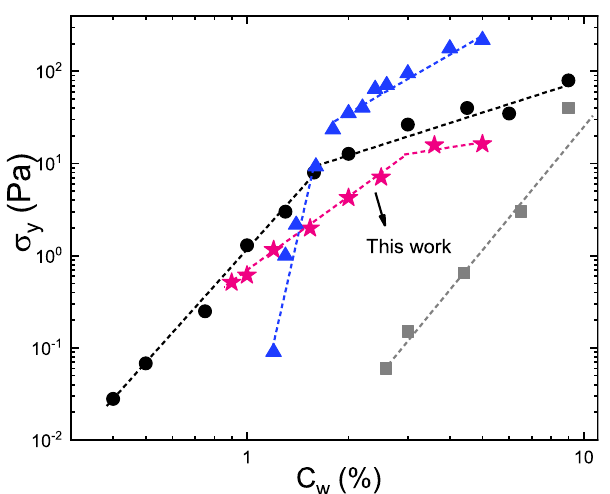
Figure 5. Yield stress for microgel with C PAAc = 24.6% at T = 311K (pink stars) obtained from the Herschel-Bulkley fit to data of Figure 2b compared with data on PNIPAM microgel (black circles) by Ghosh and coworkers [25], on soft polyelectrolyte microgel suspensions (blue traingles) by Pellet and Cloitre [23] and on ultralow crosslinked PNIPAM microgel (grey squares) by Scotti and coworkers [24].